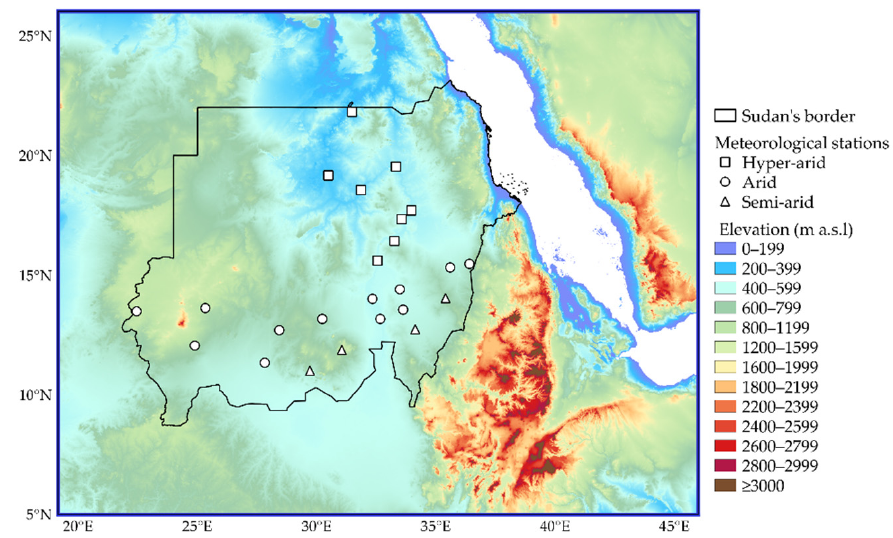
Figure 1. The domain of the Weather Research and Forecasting downscaling experiment with geographical locations of 24 meteorological stations in the hyper-arid, arid, and semi-arid zones of Sudan.